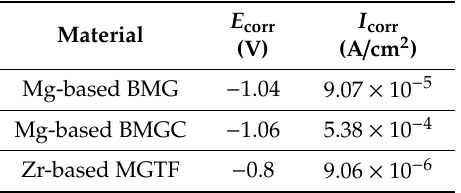
Table 3. Electrochemical parameters of the polarization test for Mg-based BMG, Mg-based BMGC, and Mg-based BMGC with Zr-based MGTF coating in 0.9 wt.% NaCl solution.